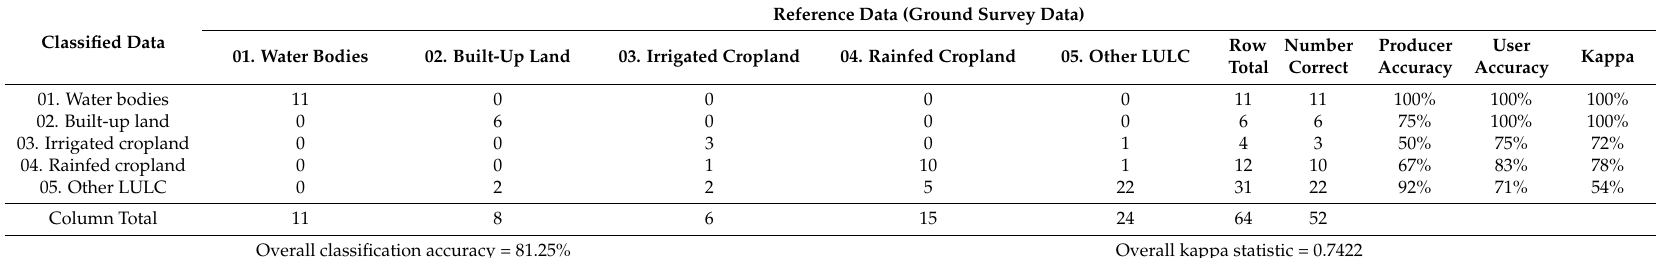
Table 3. Validation of land-use/land-cover (LULC) classes in 2005 based on ground survey data.